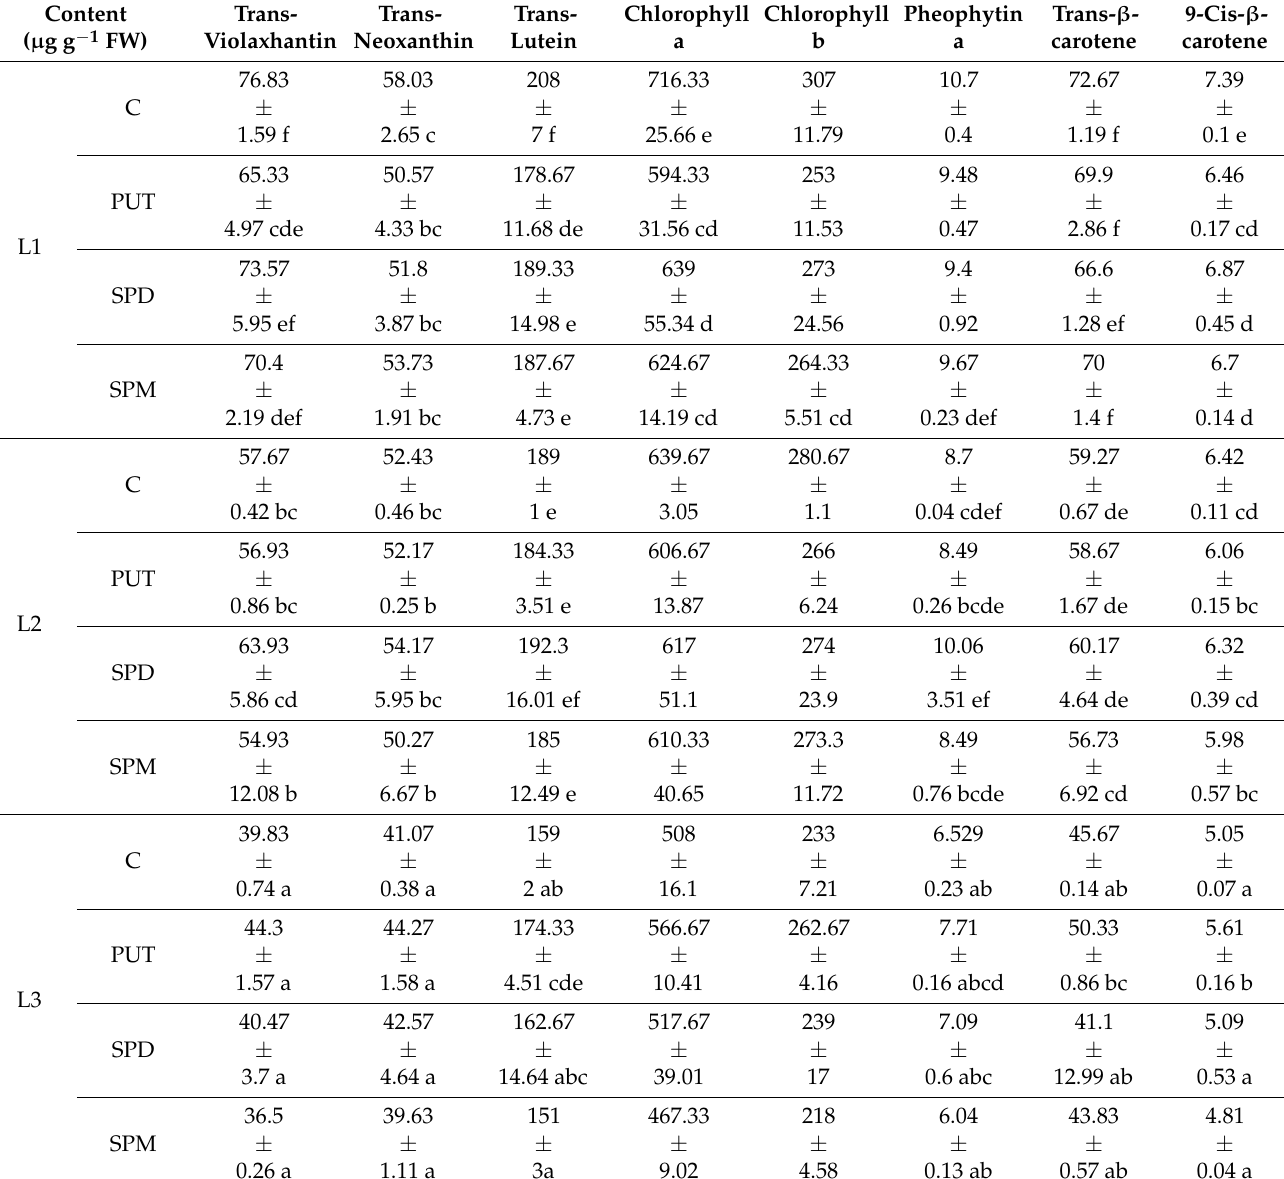
Table 2. Changes in the pigment contents under different light intensity conditions: 500 (elevated light: L1), 250 (medium (SPD) or spermine (SPM) treatments or without any treatment. Data represent mean values ± SD. Different letters indicate significant differences at p ≤ 0.05 level, among all the values of the given